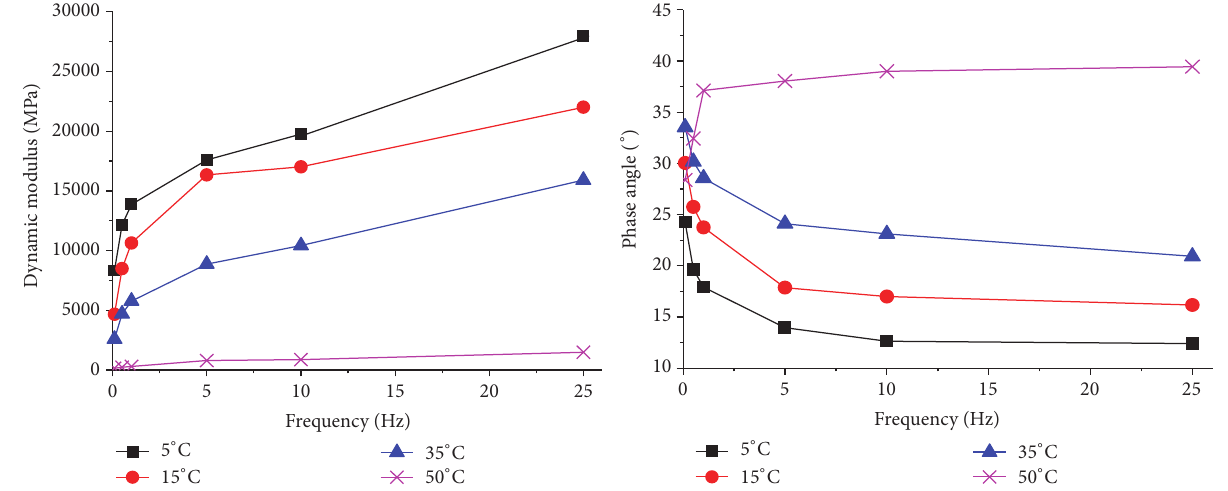
Figure 2: The dynamic modulus and phase angle of DCLR modified asphalt mixture.